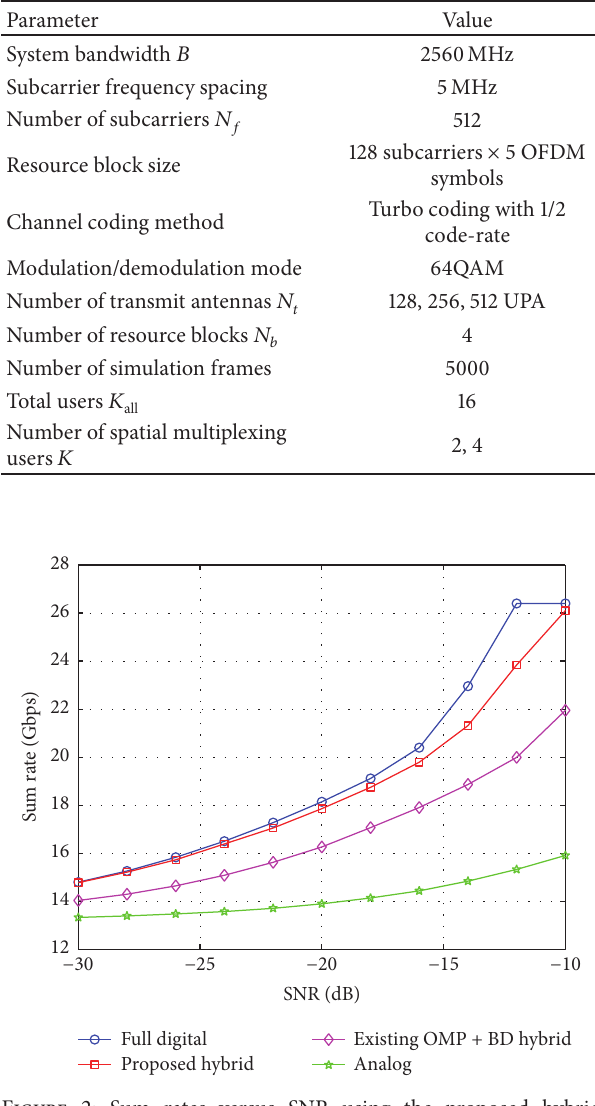
Figure 2: Sum rates versus SNR using the proposed hybrid beamforming, full digital beamforming, analog beamforming, and existing OMP + BD hybrid beamforming algorithms when 𝐾 = 2 and 𝑁 𝑡 = 512 .